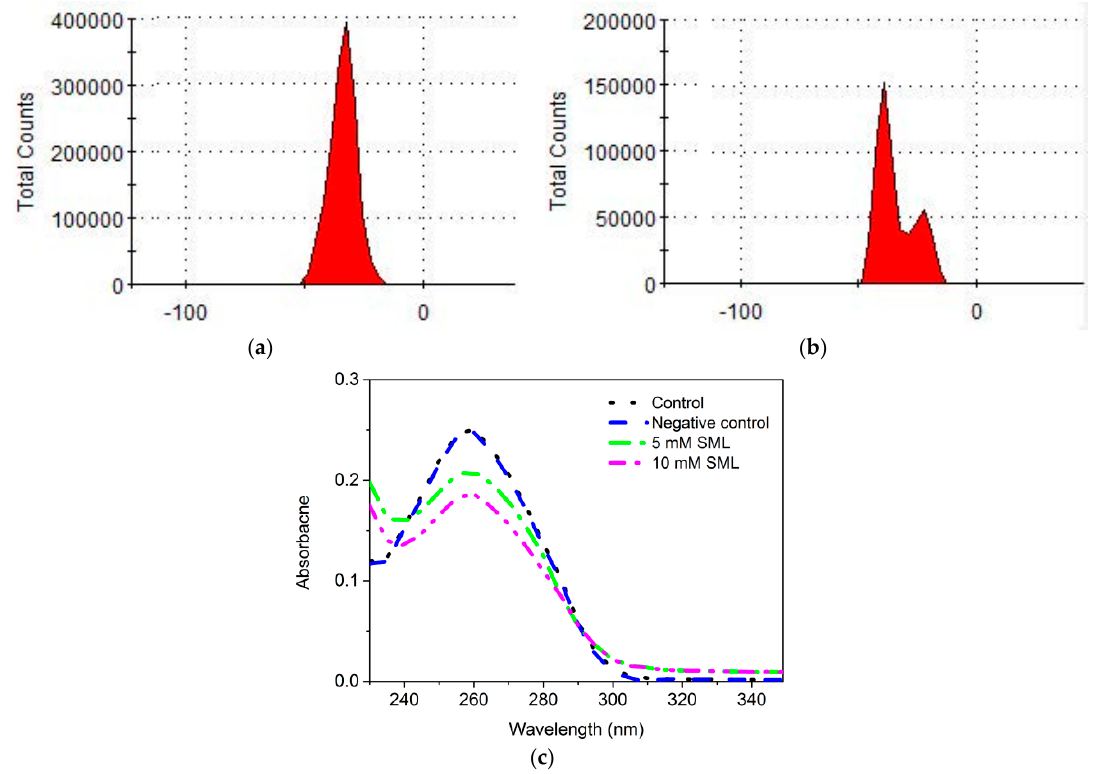
Figure 4. The effect of SML on zeta potential distribution of L. monocytogenes . ( a ) L. monocytogenes , without exposure to SML for 24 h; ( b ) L. monocytogenes , with exposure to SML for 24 h. Interaction of DNA of L. monocytogents with increasing amounts of SML; ( c ) Ultraviolet spectroscopic measurements.